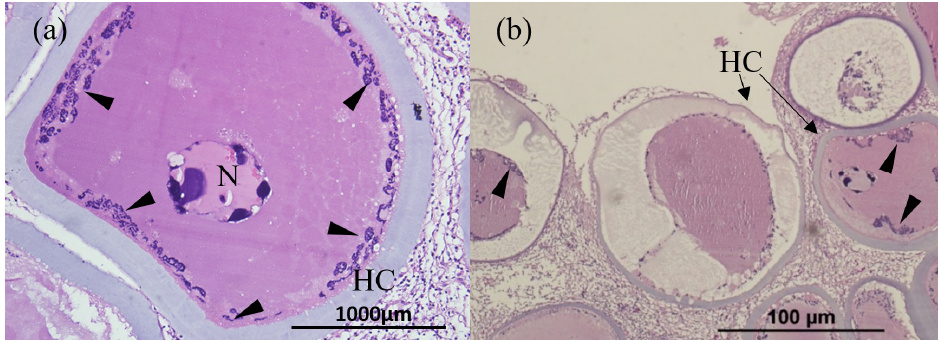
Figure 4. Histopathological findings of hypertrophic lymphocystis cells: ( a ) 100 × view of single hypertrophic lymphocystic cell and ( b ) 100 × view of lesion tissue on skin. HC: hyaline capsule; Arrowhead: intracytoplasmic inclusion bodies; N: